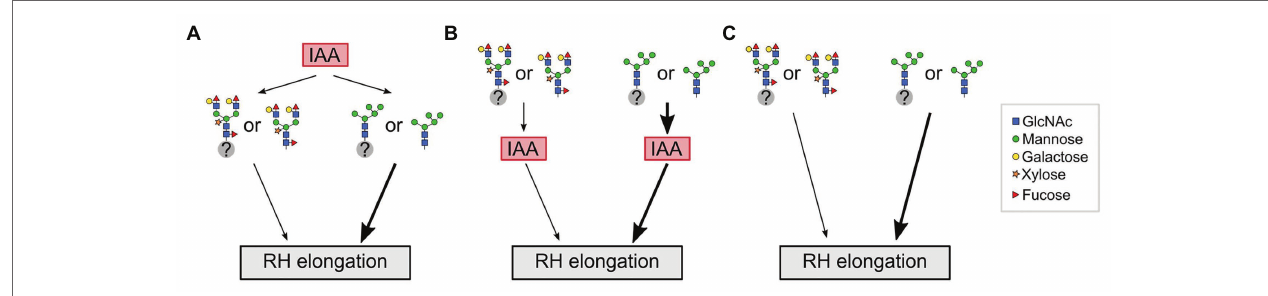
FIGURE 5 | Potential interplay between auxin (IAA) and complex N-glycosylation during RH elongation. (A) In wild-type roots with fully matured complex N-glycans, a (group of) yet unknown N-glycosylated factor(s) (gray circle with question mark) or free N-glycans act downstream of auxin (indole acetic acid, IAA) to regulate RH elongation. An impairment of fully matured N-glycans in complex glycosylation mutants (depicted by N-glycans as they appear in gntI ) results in exaggerated elongation of RHs (thick black arrow). (B) Complex N-glycosylation acts upstream of IAA to regulate RH elongation. An impairment of fully matured N-glycans in complex glycosylation mutants results in exaggerated RH elongation by enforcing the auxin output. (C) Complex N-glycosylation acts independent of IAA on RH elongation. RH, root hair; GlcNAc,